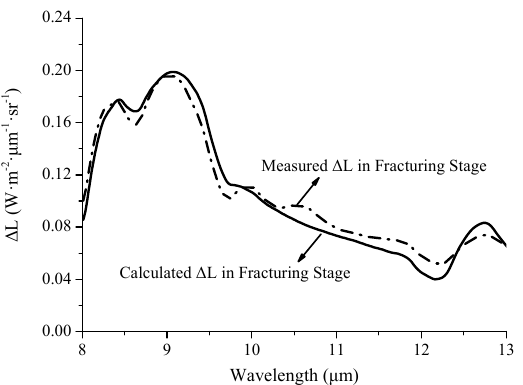
Figure 9. Measured and calculated Δ L spectrum of the cavity effect for sample sy20–3.